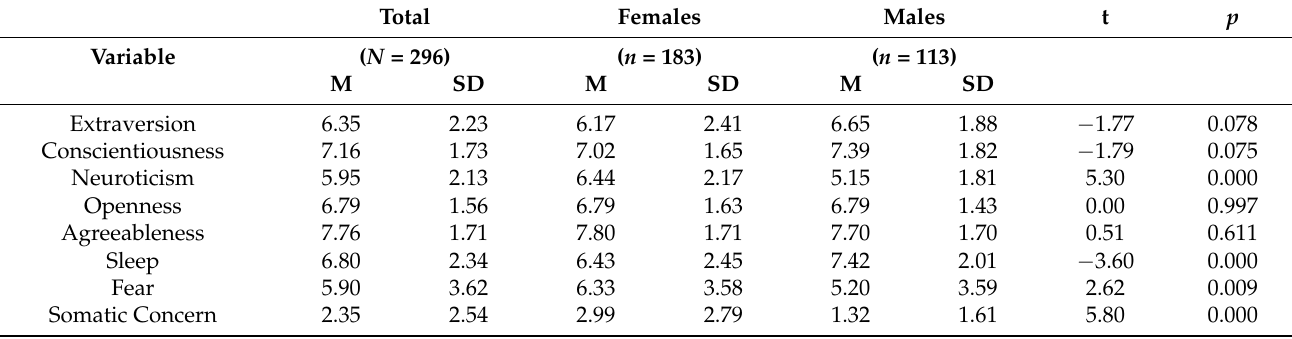
Table 2. Means (M), standard deviations (SD), and independent sample t-tests on all measures.